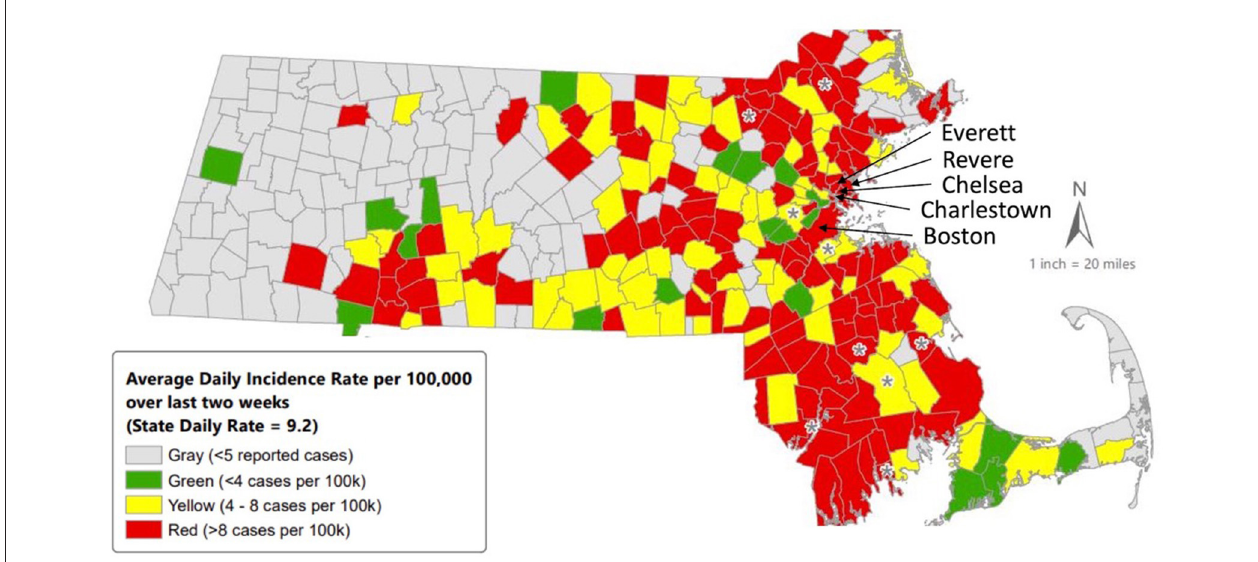
FIGURE 1 | Average daily incidence rate (per 100,000, PCR only) for COVID-19 in Massachusetts by City/Town, 10/11/2020–10/24/2020. Citation: https://www. mass.gov/doc/weekly-covid-19-public-health-report-october-29-2020/download. Accessed November 17,